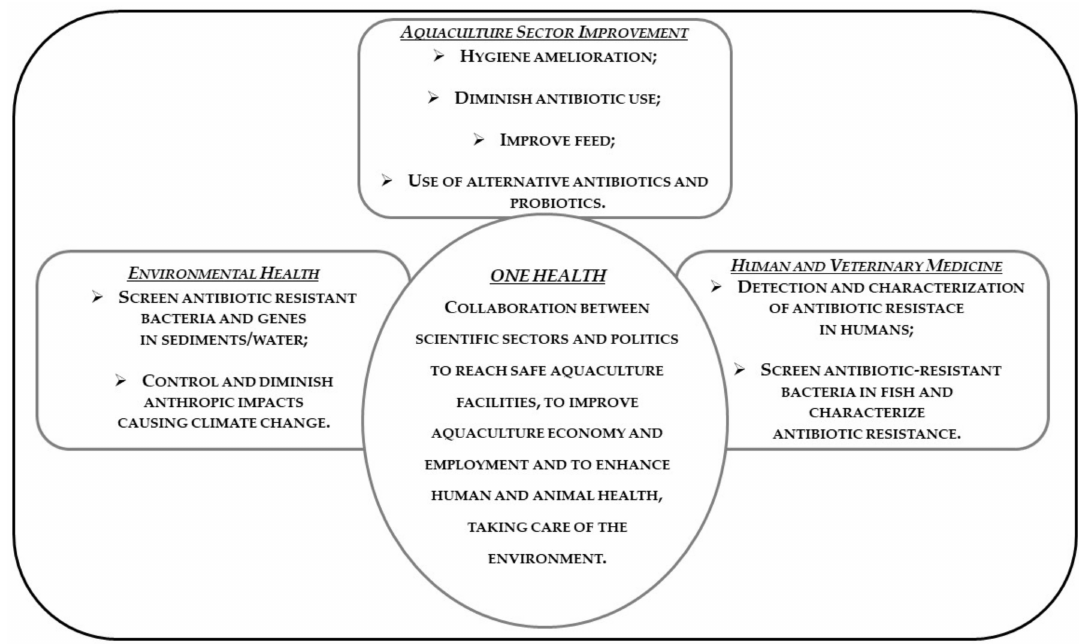
Figure 2. One Health possible approach for the antibiotic resistance concern in the Mediterranean